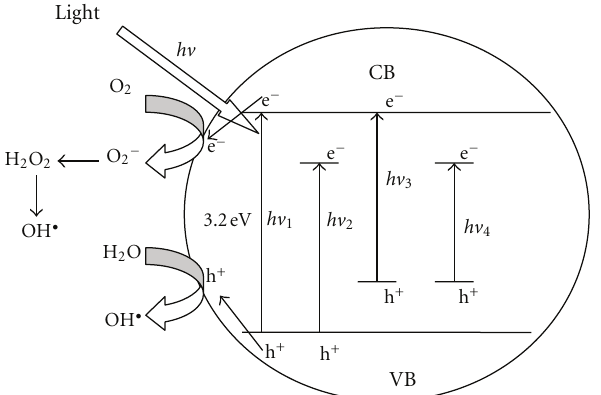
Scheme 1: Schematic representation of the mechanism of photocatalytic titanium dioxide particles (TiO 2 : hv 1, Fe-TiO 2 : hv 2 , N-TiO 2 : hv 3 , Fe-N-TiO 2 : hv 4